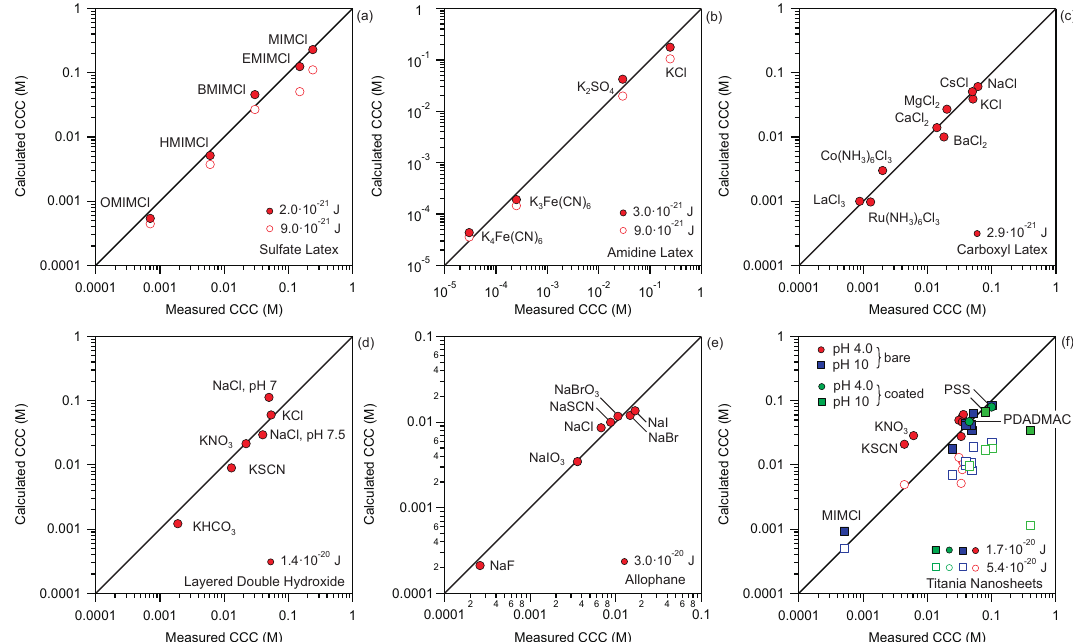
Figure 3. Calculated versus measured CCCs for different systems. Full symbols adjusted Hamaker constant, empty symbols theoretical Hamaker constants. ( a ) Sulfate latex particles in the presence of imidazolium based salts [35]. ( b ) Amidine latex particles in the presence of multivalent anions [50]. ( c ) Carboxyl latex particles in the presence of mono and multivalent cations [56]. ( d ) Layered double hydroxide platelets in the presence of monovalent salts [45]. ( e ) Allophane clay nanoparticles in the presence of monovalent anions [57]. ( f ) Bare and coated titania nanosheets in the presence of monovalent satls [36,49,58]. Theoretical values of Hamaker constants for polystyrene latex particles and titania particles of 9.0 · 10 − 21 [53] and 5.4 · 10 − 20 [59] are used, respectively. All the points in the figure are listed in Table